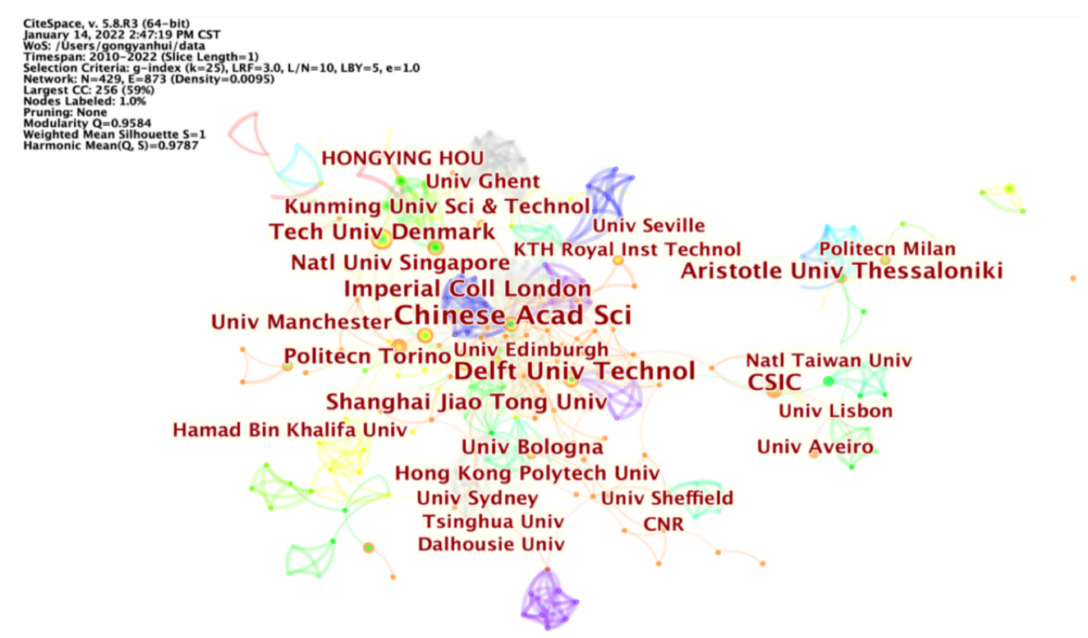
Figure 4. Institutional cooperation